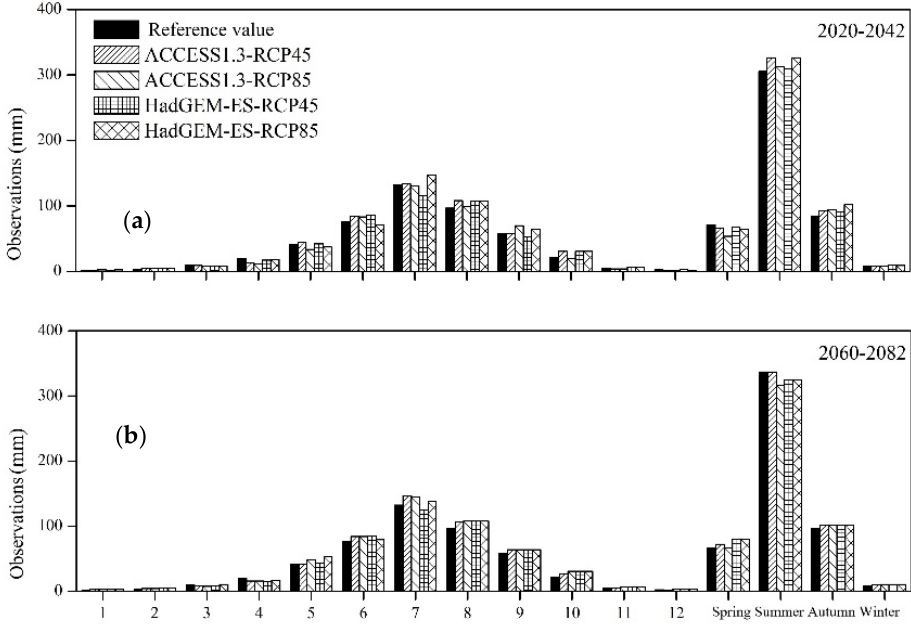
Figure 8. Projected mean of precipitation under the different combinations of GCMs and RCPs scenarios during the different assessment periods ( a ) from 2020 to 2042; ( b ) from 2060 to 2082.